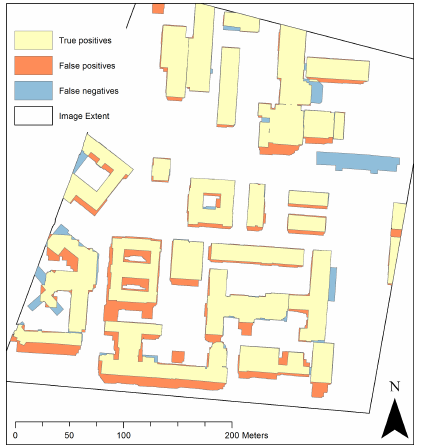
Figure 6: Detection results using our approach